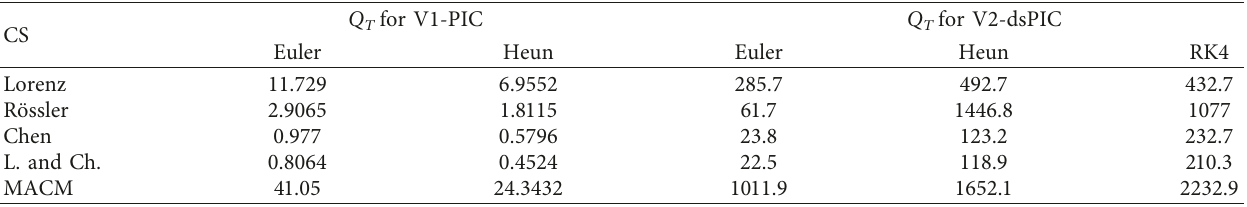
Table 11: Performance of the ES expressed in Q T of the 3D Lorenz, R¨ossler, Chen, Liu and Chen, and MACM CSs in their DVs using (6)–(8) for V1, and (6)–(13) for V2.